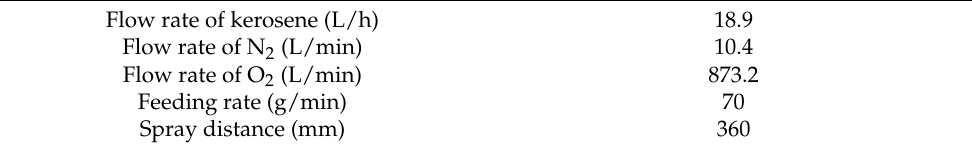
Table 1. Main parameters for HVOF-sprayed NiCoCrAlYCe coatings.